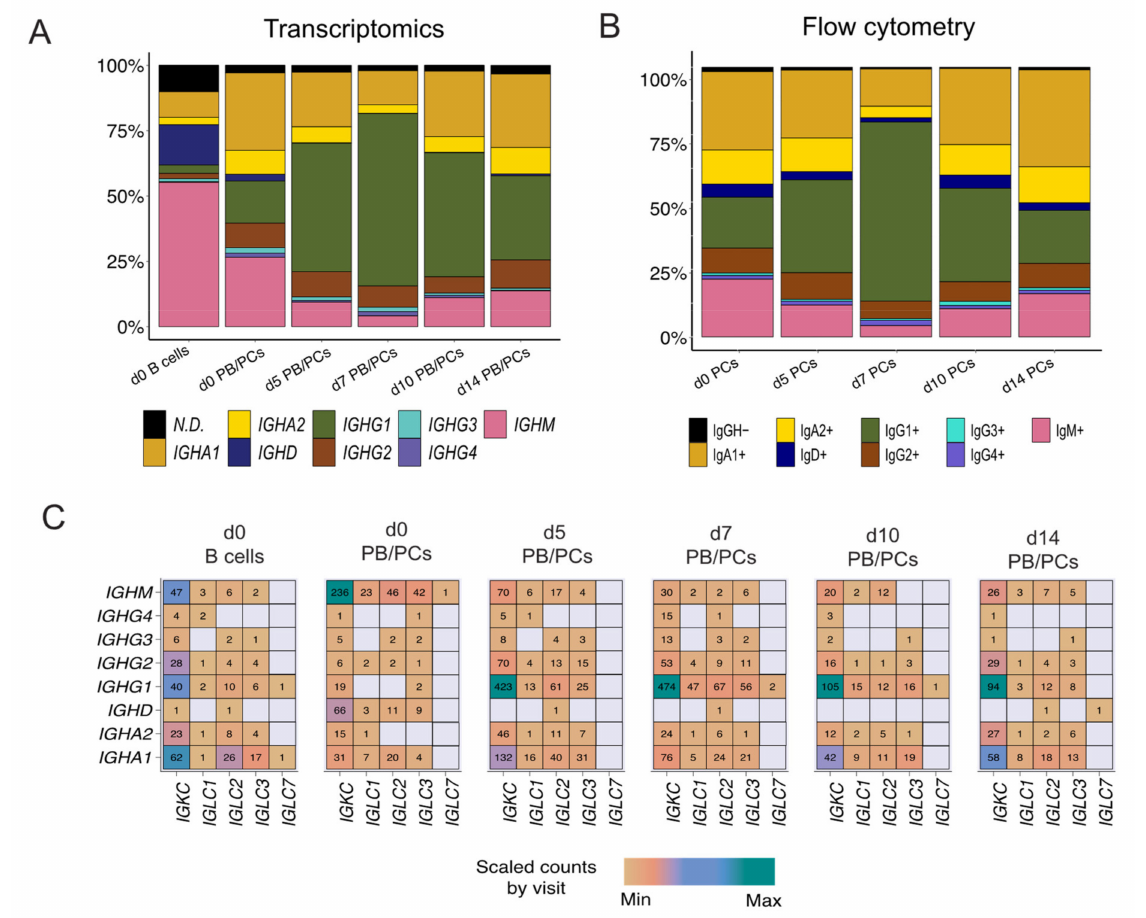
Figure 4. The dynamics of heavy and light constant gene usage in the BCRs over different time-points pre- and post- vaccination. ( A ) Usage of IGH constant genes in single-cell BCRs over time. The PB/PCs and B cells at the d0 are considered separately. ( B ) Over time usage of constant genes in the PB/PCs as identified by flow cytometry (based on membrane and intracellular Ig expression). ( C ) The usage of heavy and light constant genes across different visits. The numbers in the heatmap are the number of chains using a given pair and the colors are ranged based on the scaled counts for each